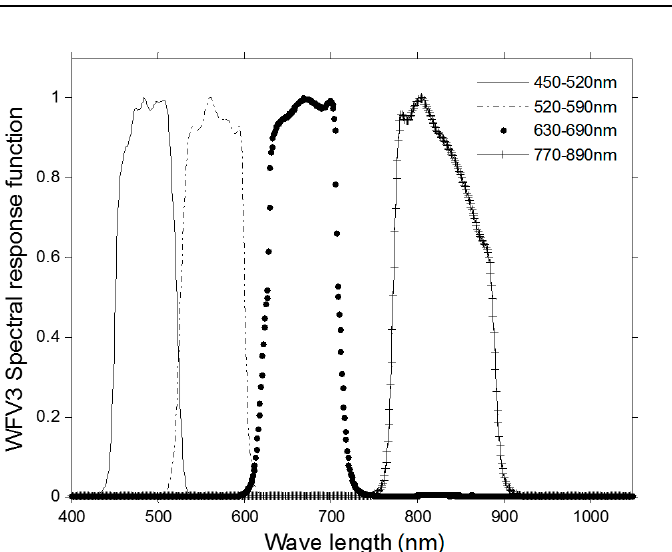
Figure 1. Spectral response functions of the third Wide Field Viewing camera onboard Gaofen-1 satellite (GF-1/WFV3).